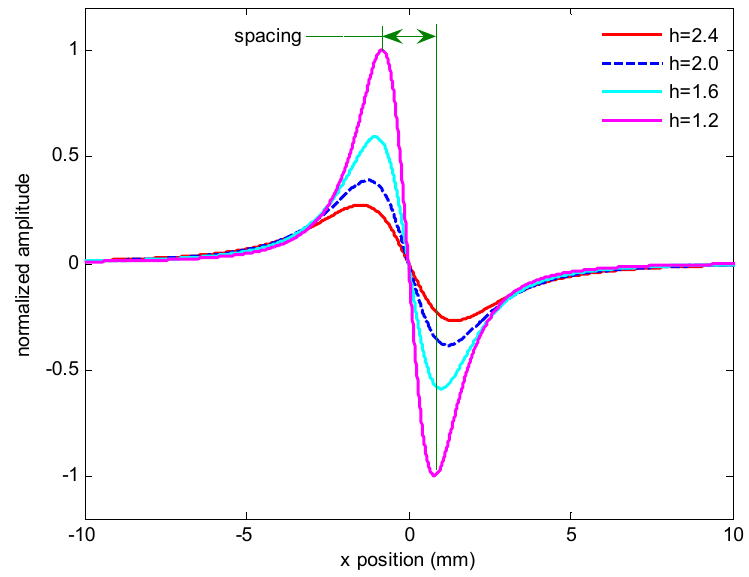
Figure 3. Typical signals H x predicted by line magnetic dipole model.